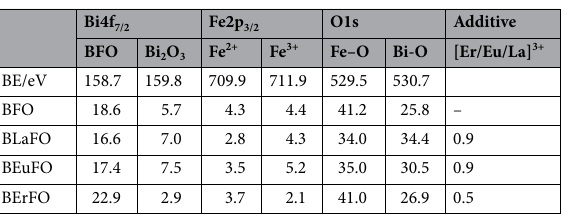
Bi4f 7/2 Fe2p 3/2 O1s Additive BFO Bi 2 O 3 Fe 2+ Fe 3+ Fe–O Bi-O [Er/Eu/La]